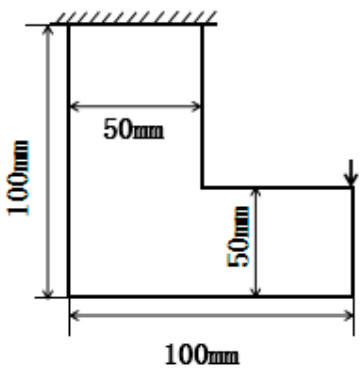
Figure 5. A loaded knee structure.